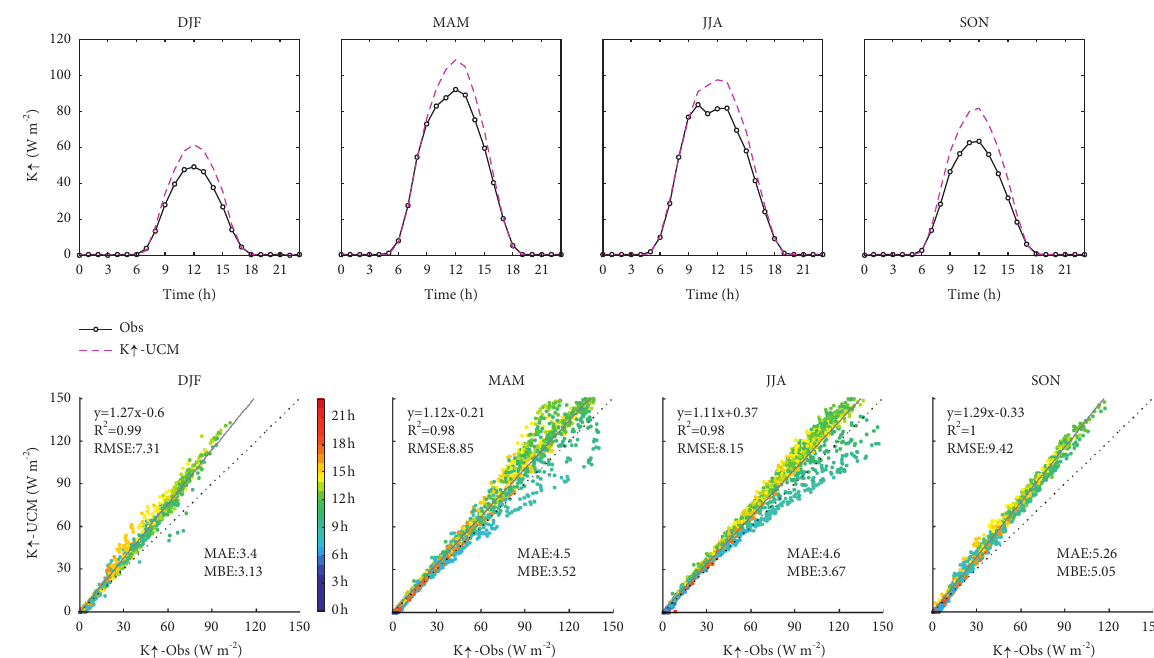
Figure 4: The same as Figure 3, but for the upward shortwave radiation (K ↑ each parameter. In order to improve the efficiency, here a loop is added into SLUCM to realize the automatic incre- ment of parameters. Table 1 lists the default values and variation ranges of main parameters of SLUCM. These parameter values are mainly obtained from reference [28].